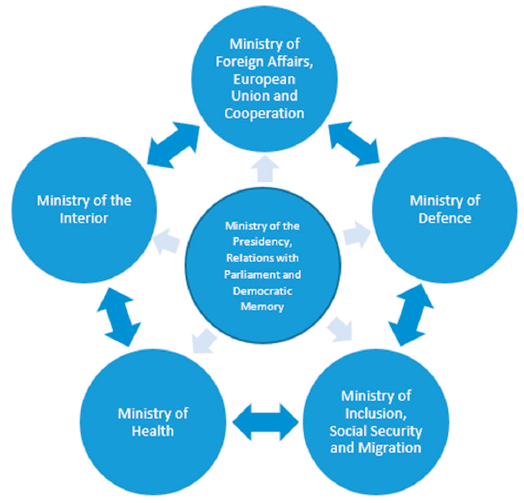
Figure 1. Inter-Ministerial Coordination Commission.